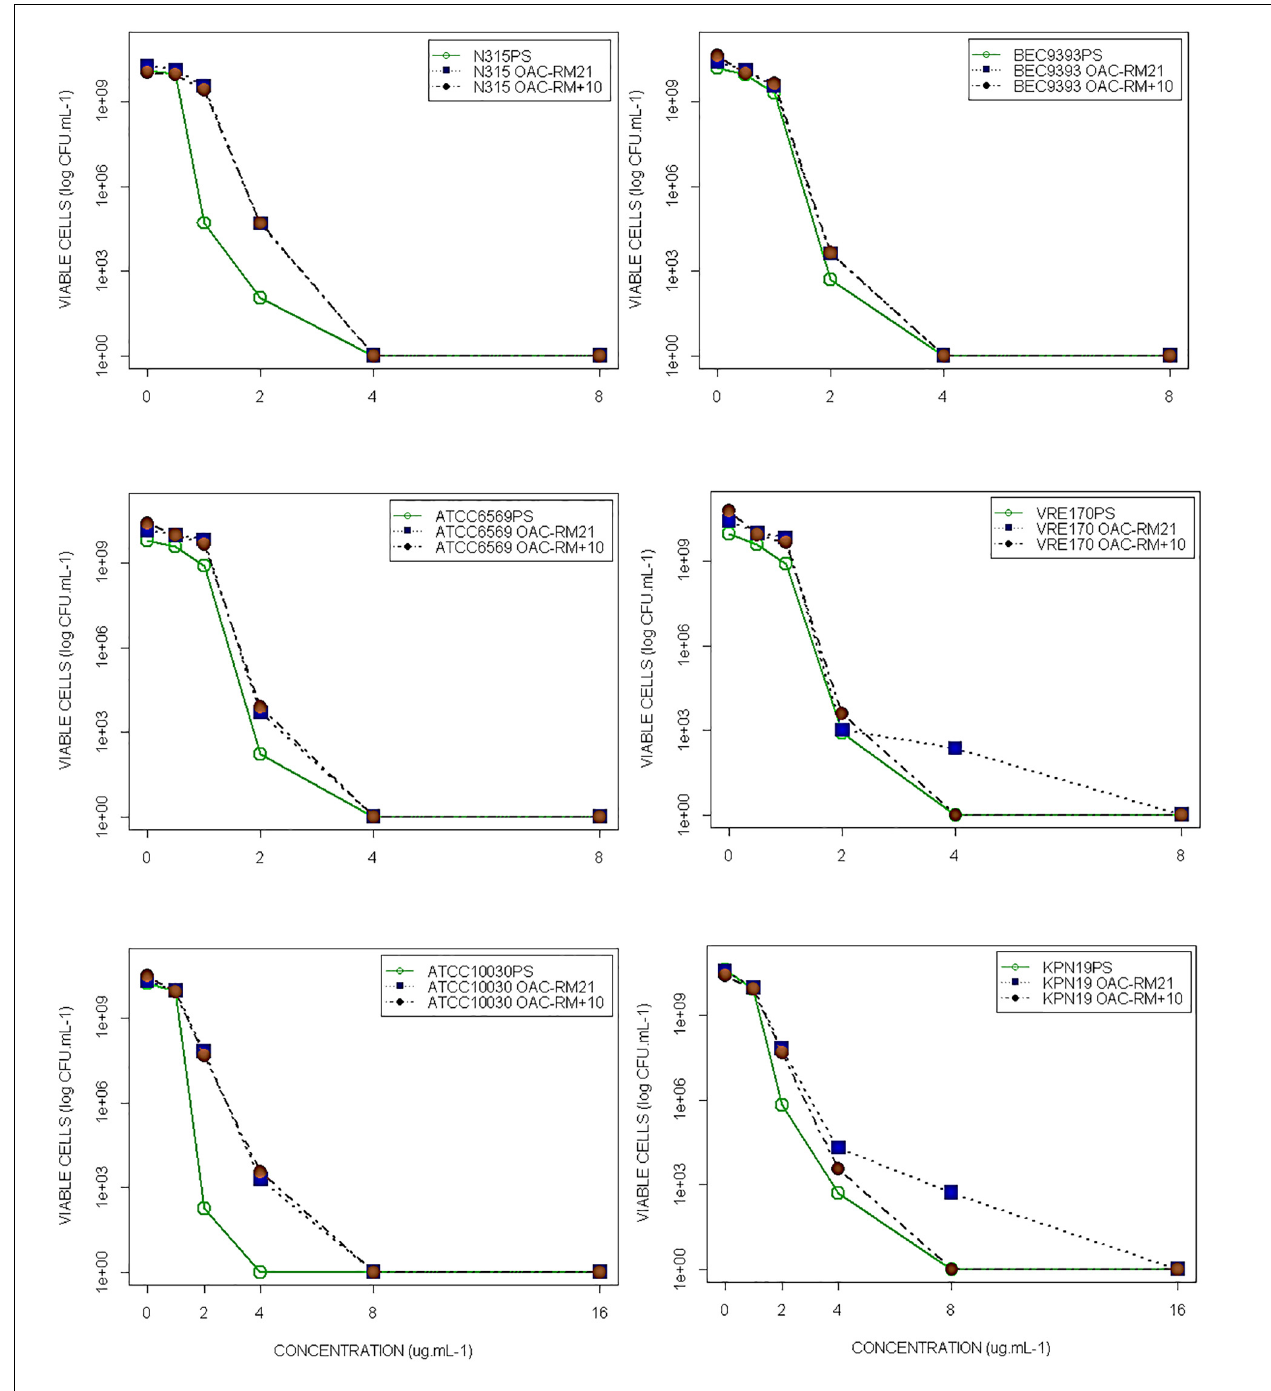
FIGURE 2 | Fluopsin C-MPC determination with S. aureus (MRSA N315 and MRSA BEC9393), E. faecium (ATCC6569 and VRE 170) and K. pneumoniae (ATCC 10031 and CRE-Kpn19) parent and FC-RMs strains.